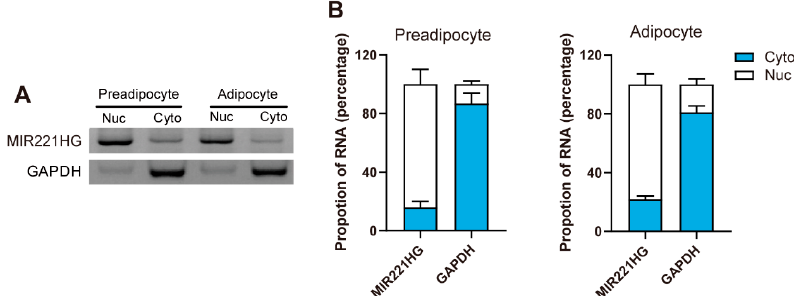
Figure 3. Multiple forkhead box C1 (FOXC1) and krüppel-like factor5 (KLF5) putative binding sites are predicted in the MIR221HG promoter region. ( A ) Predicted FOXC1 and KLF5 binding sites within a 2000-bp region of the MIR221HG promoter. ( B ) FOXC1 binding motif sequence logo from JASPAR. ( C ) KLF5 binding motif sequence logo from JASPAR.